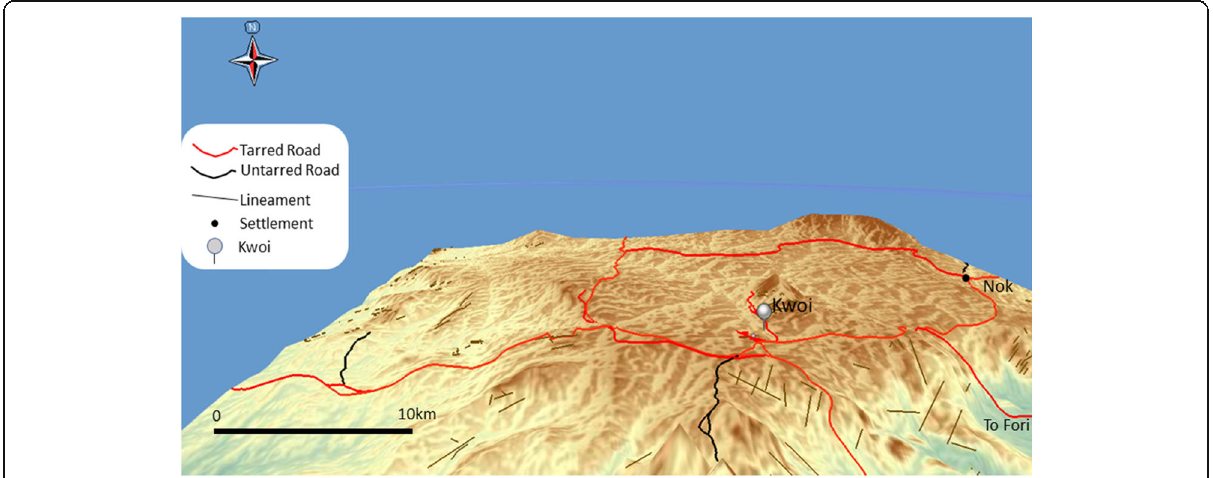
Fig. 1 Digital Terrain Model (DTM) of Kwoi and environs displayed in 3-dimension with Kwoi town indicated by a small globe. Roads and lineaments have been overlayed for locational